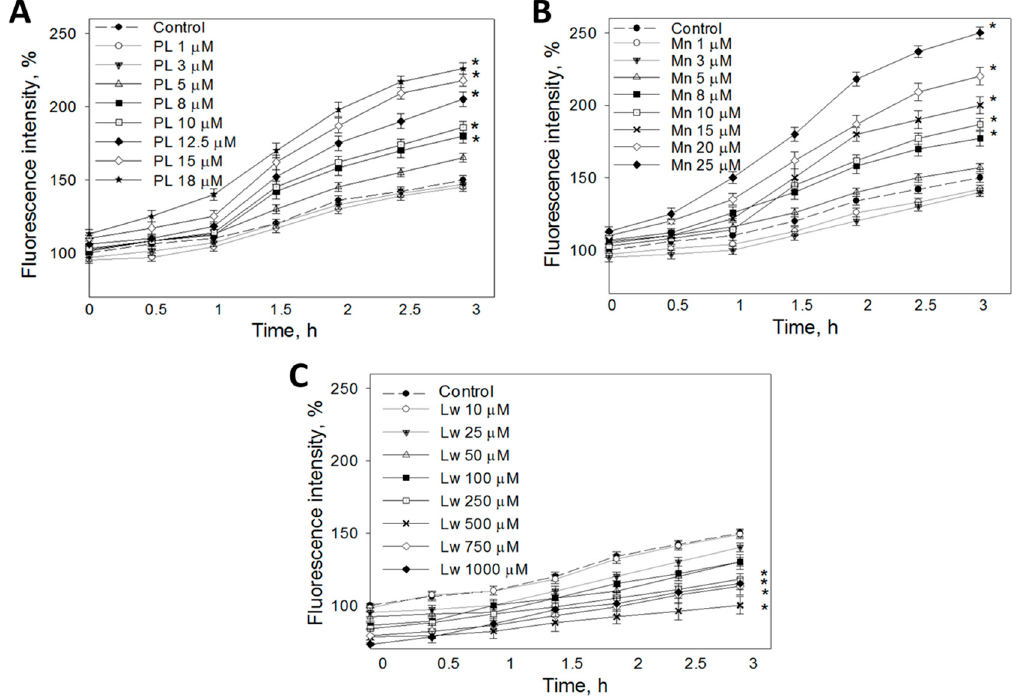
Figure 3. E ff ects of di ff erent concentrations of ( A ) plumbagin, ( B ) menadione, and ( C ) lawsone on intracellular ROS concentration. C6 cells were pre-treated with 10 μ M DCFH-DA and then incubated with di ff erent concentrations of investigated compounds. Fluorescence intensity, which is proportional to the intracellular ROS concentration, was detected by a fluorometer at excitation and emission wavelengths of 544 and 590 nm, respectively. Data are presented as means of the percentage of control cells ± SE ( n = 5). * p < 0.05 versus